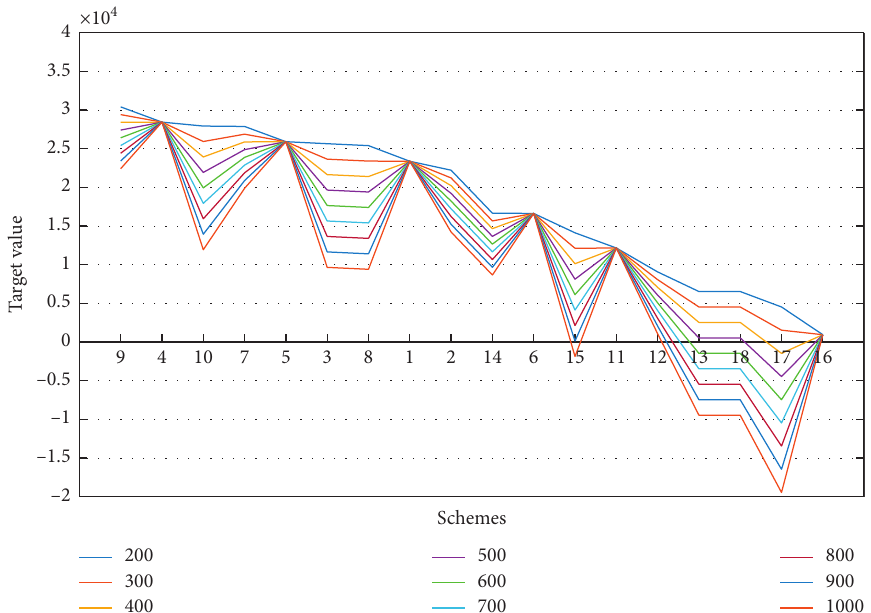
Figure 10: C � 3: target values of various schemes under different train adjustment cost coefficients of existing z